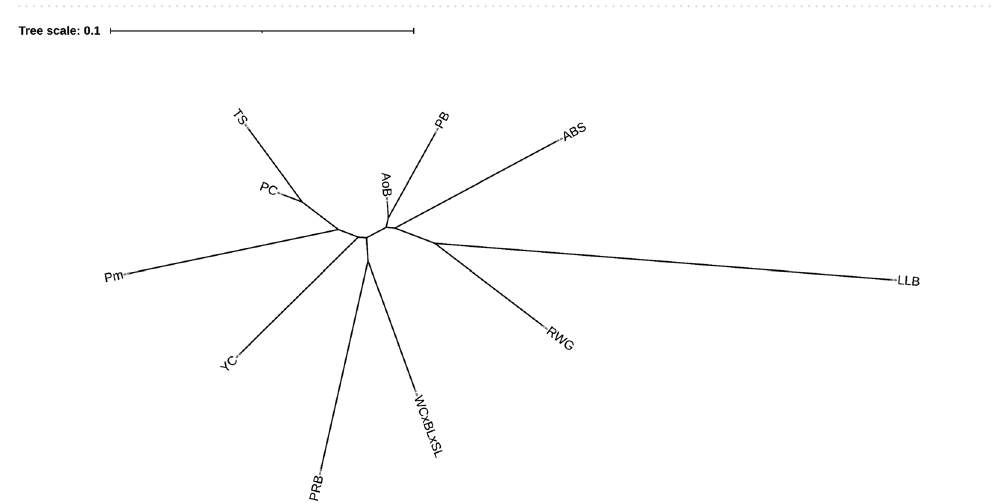
Figure 7. Phylogenetic tree based on pairwise F ST genetic distances and built using the Neighbor-Net